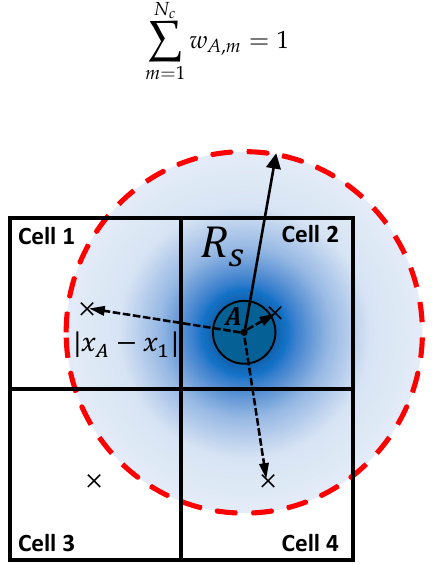
Figure 1. Cells, particle, and support region.